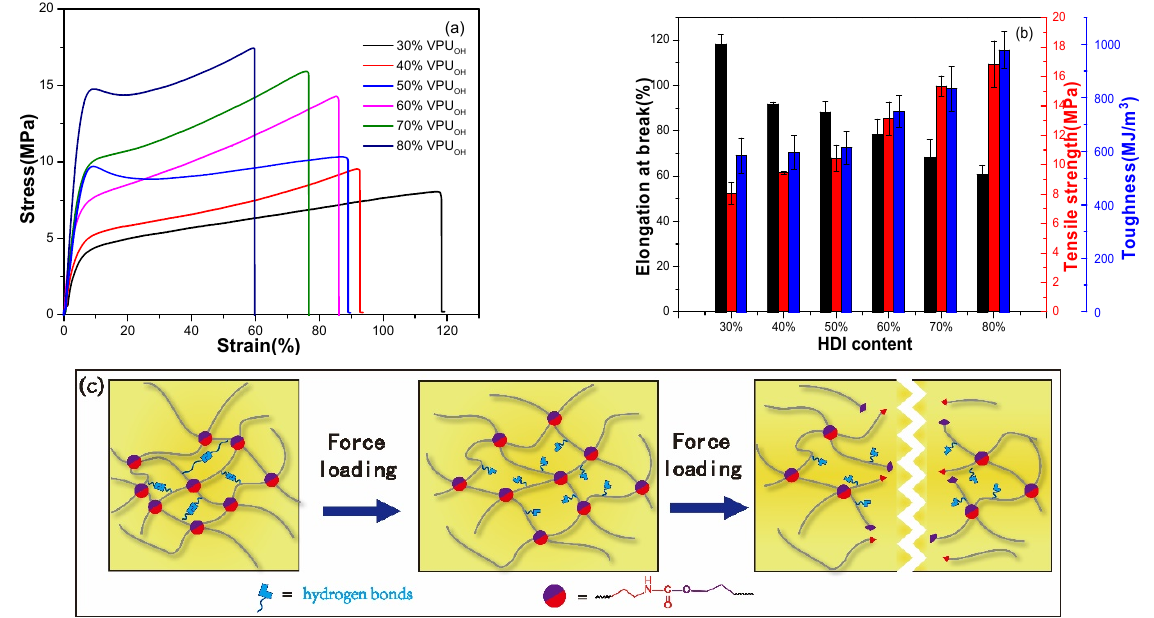
Figure 3. Mechanical properties of PEMPA and the VPU OH series with different HDI content. ( a ) Curve of stress–strain, ( b ) Mechanical properties of the x%VPU OH series with different crosslinker content, ( c ) Schematic representation of the hydrogen bonds. Table 1. Mechanical and thermal properties of the VPU OH series with different HDI content. Sample